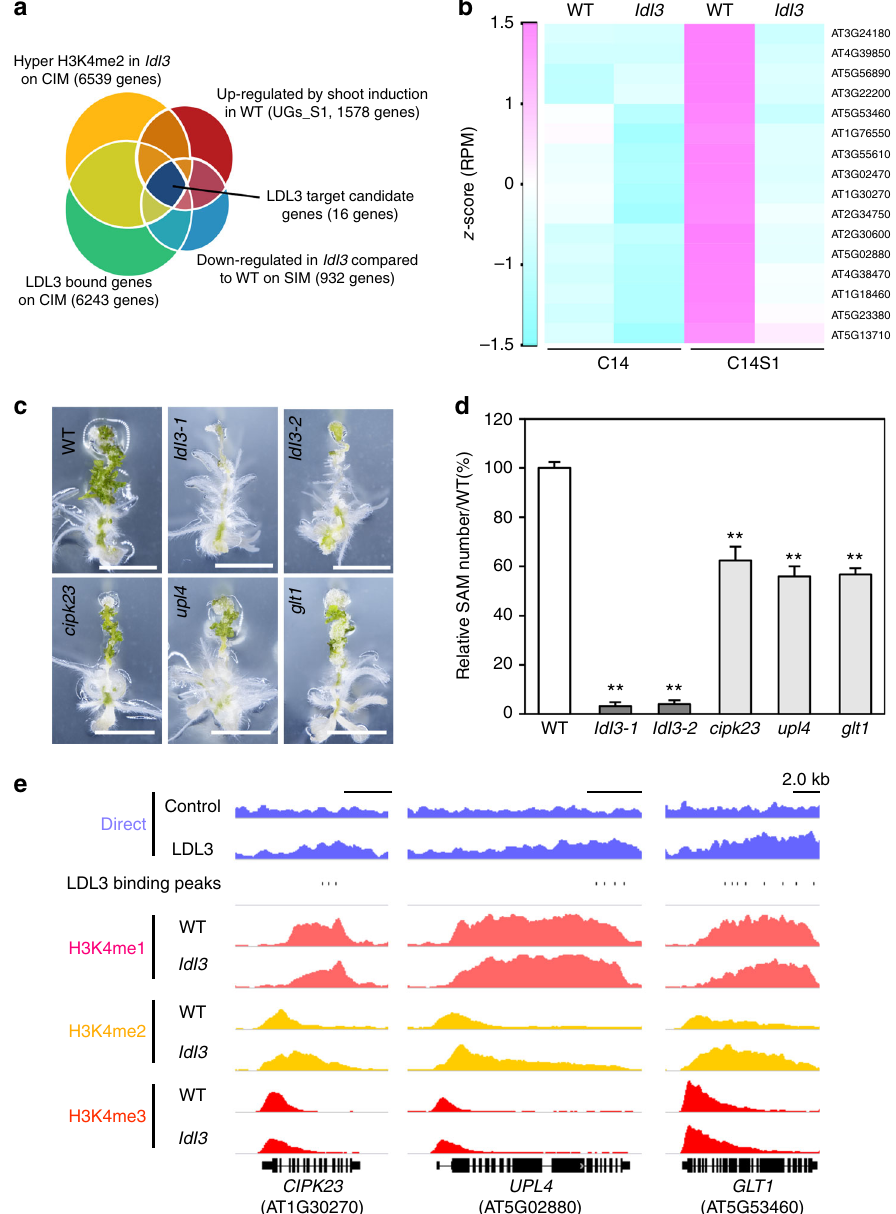
Fig. 7 Identi fi cation of LDL3 target genes involved in shoot regeneration. a Venn diagram of the genes with hyper H3K4me2 in ldl3-1 compared with WT (C14), the genes upregulated upon shoot induction in WT ( p < 0.01, FC > 1.25) (S1), the genes down-regulated in ldl3-1 compared with WT upon shoot induction ( p < 0.01, FC < 0.8) (UGs_S1), and LDL3-bound genes (C14). b Heat maps for gene expression levels ( z -score of RPM) of putative LDL3 targets (16 genes) in WT and ldl3-1 before and after shoot induction. c , d Shoot regeneration phenotype in the three mutants for three putative LDL3 target genes. Values are mean ± s.d. ** p < 0.01 (Student ’ s t -test). 71 < n < 80. Scale bars: 5 mm. e Histone H3K4 methylation and LDL3 binding patterns in putative target genes. Boxes, exons; thin lines, introns; bold lines at both ends, 5 ′ or 3 ′ UTR. See also Supplementary Fig. 7, Supplementary Data 5 and 6. Source data